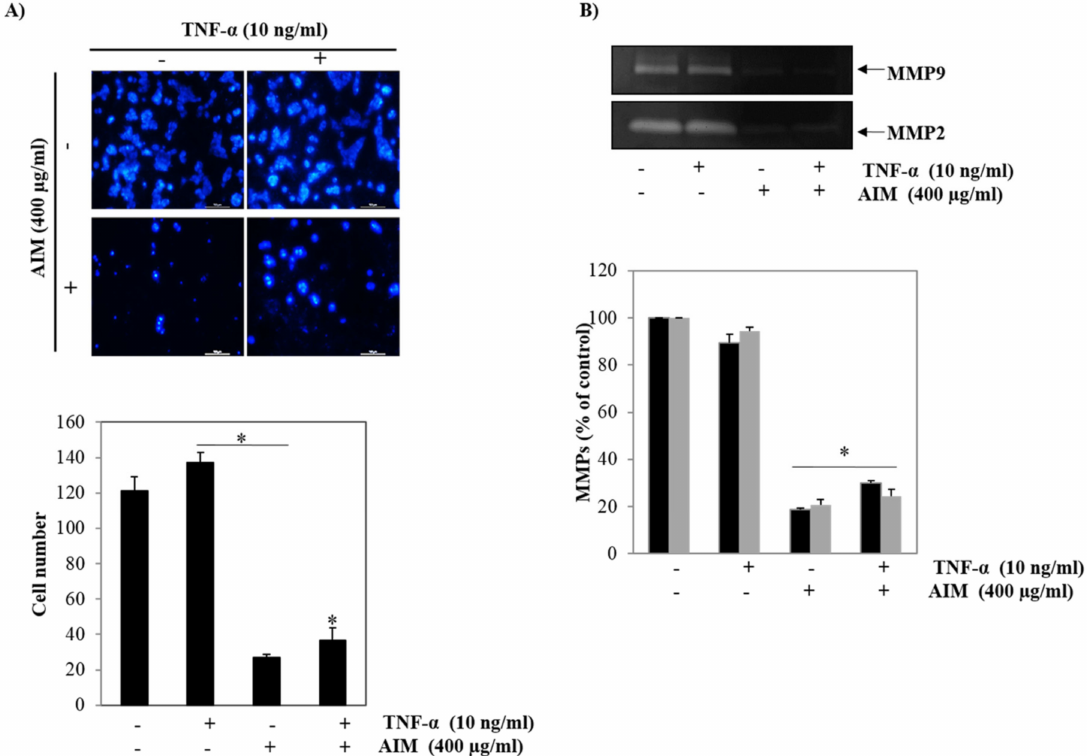
Figure 3. Inhibitory e ff ects of AIM on the expression of TNF-treated MMP-2 and MMP-9 in MCF-7 cells. ( A ) AIM greatly influenced TNF- α -stimulated cell invasion of MCF-7 cells. (Upper) The Transwell invasion assay was performed using a Boyden chamber treated with or without TNF- α in the presence of AIM (400 µ g / mL) at 37 ◦ C for 24 h in a CO 2 incubator. (Lower) Graphical representation of the number of invasive cells present were expressed in percentage. ( B ) MCF-7 cells were treated with TNF- α . (Upper) MMP-2 and MMP-9 protein secreted in the treated medium was used for the gelatin zymography analysis. (Lower) MMP-2 and MMP-9 enzyme activities were expressed in percentage and compared against the untreated cells. Data are the mean ± SD values of three independent experiments. * p < 0.05 versus the